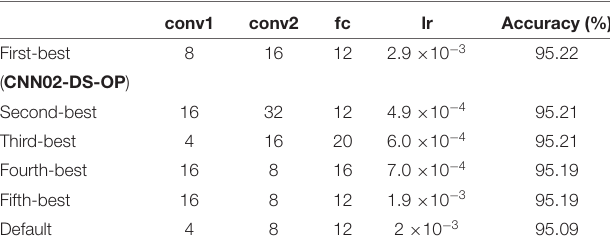
TABLE 7 | Classification accuracy for the five top-performing and default ( CNN02-DS ) hyperparameter configurations. conv1